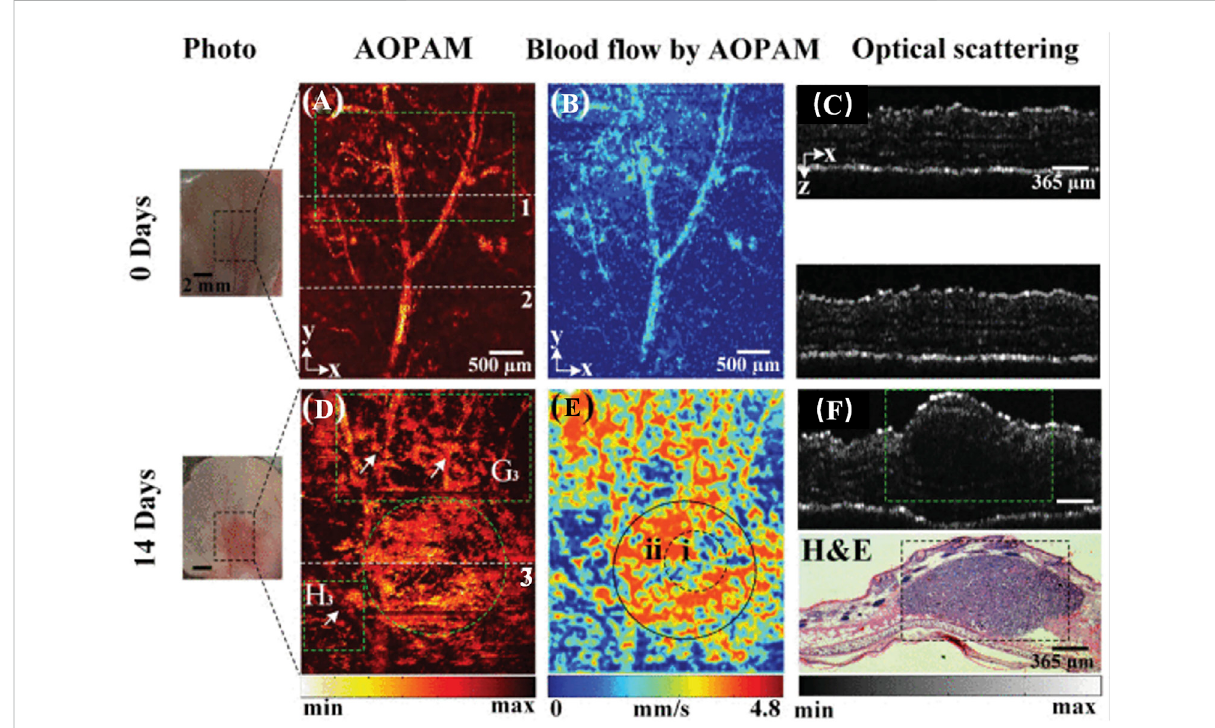
FIGURE 5 AOPA/OCT images of melanoma progression in vivo . (A,D) AOPAM optical absorption of intensity images. (B,E) Blood fl ow images by AOPAM. (C,F) OCT images corresponding to the white dotted lines 1-3 in (A,D) . H&E, hematoxylin and eosin-stained histologic image corresponding to OCT image in (F) (reproduced from (Zhou et al., 2020) with permission from IEEE Transactions on Medical